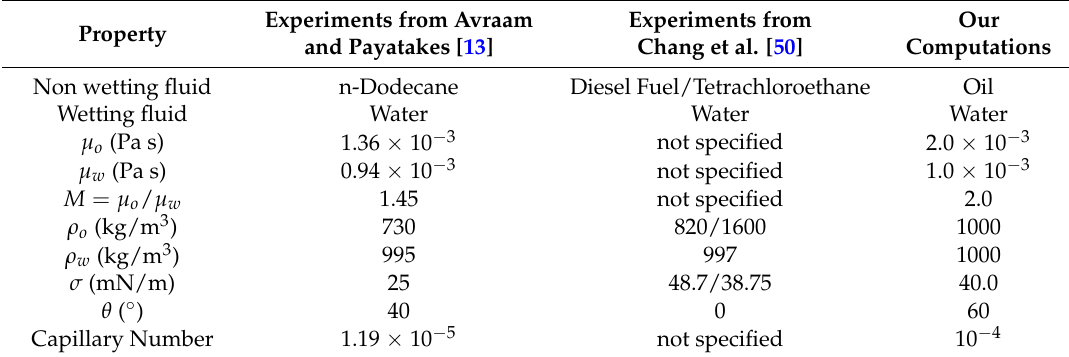
Table 4. Physicochemical properties of fluids employed by Avraam and Payatakes [13], and Chang et al. [50] and used in this